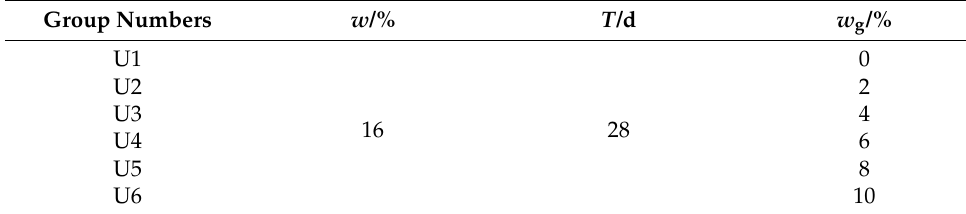
Table 2. Experimental design of UCS.